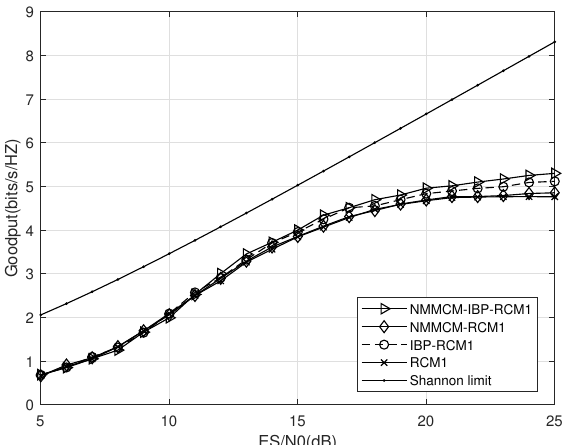
Figure 6. Goodput comparison in different system with weight set {± 1, ± 1, ± 2, ± 2 } .